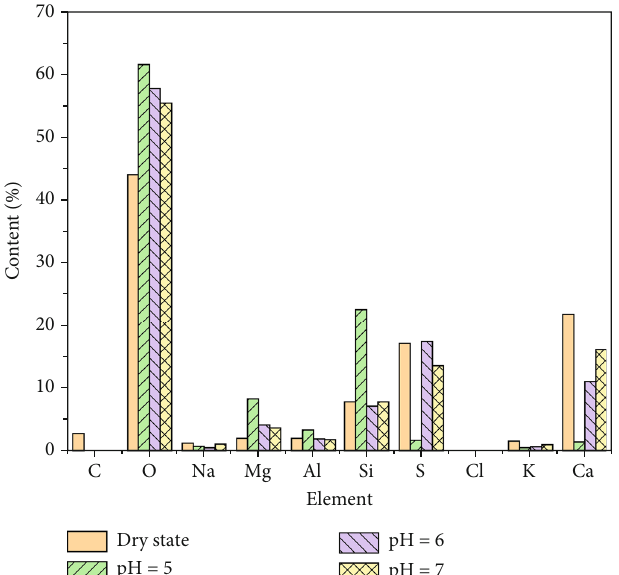
Figure 6: The content of elements on the rock surface under various experimental conditions.